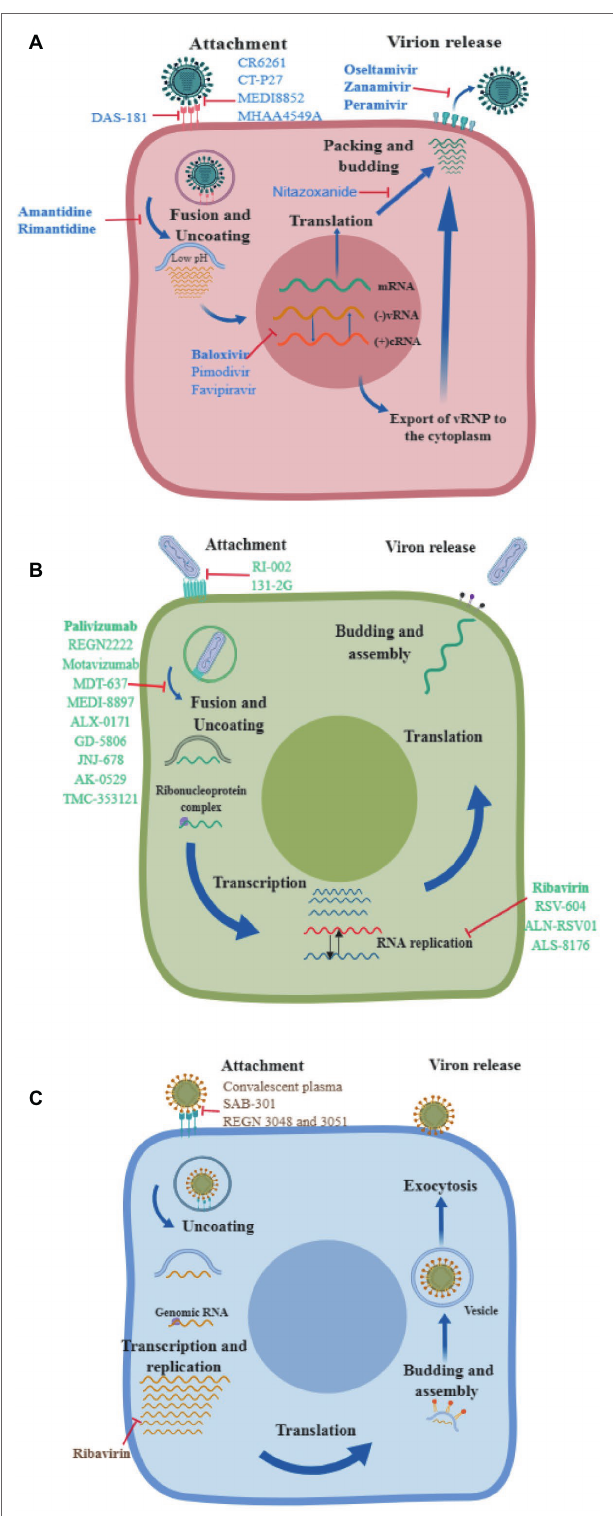
FIGURE 1 | Mechanisms of action of different antivirals. A diagram of the virus life cycle of (A) influenza virus, (B) respiratory syncytial virus, and (C) Middle East respiratory syndrome coronavirus, indicating where each therapeutic exerts its antiviral activity. Drugs approved by the FDA are shown in